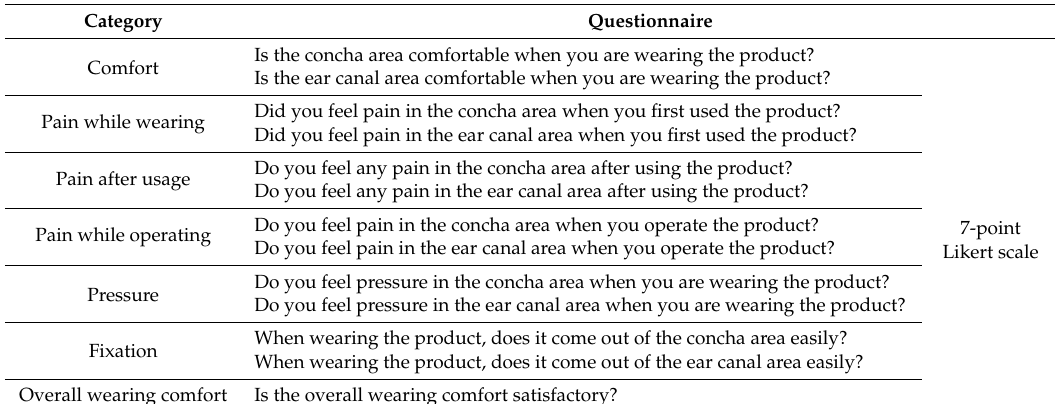
Table 3. Evaluation questionnaires for wearing